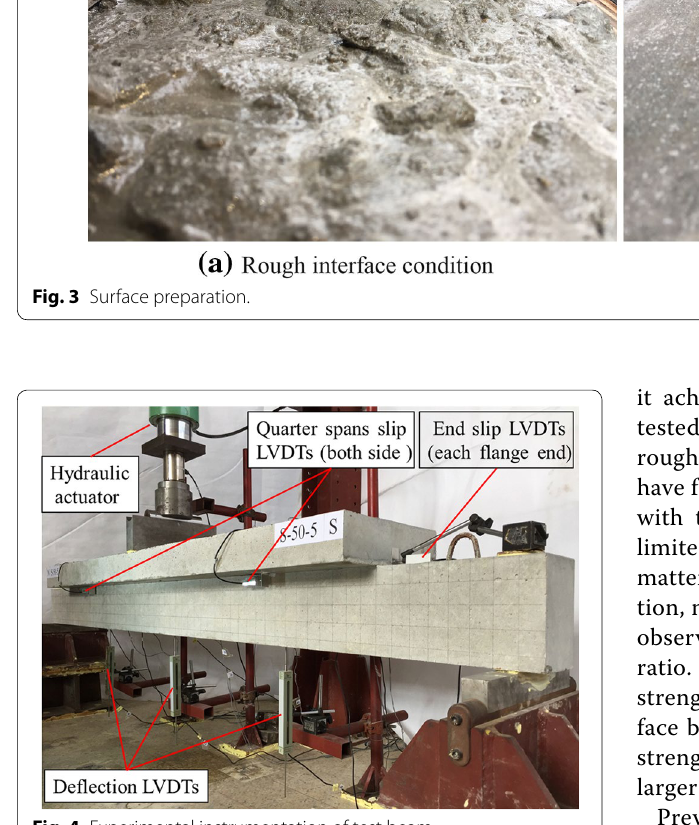
Fig. 4 Experimental instrumentation of test